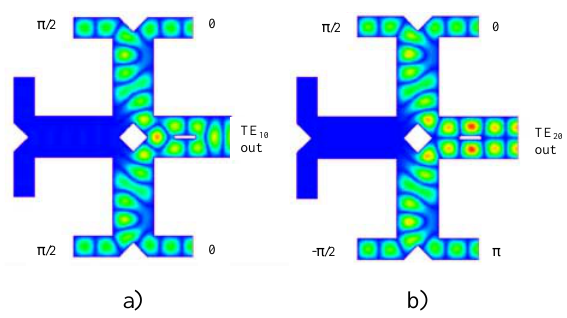
FIG. 2. (Color) Cross potent launcher with simulated electric field plots illustrating launching (a) TE 10 and (b) TE 20 in the right overmoded rectangular port with the indicated relative phases for four equal amplitude inputs. Alternate phasings of the inputs send the power to either of the left ports.